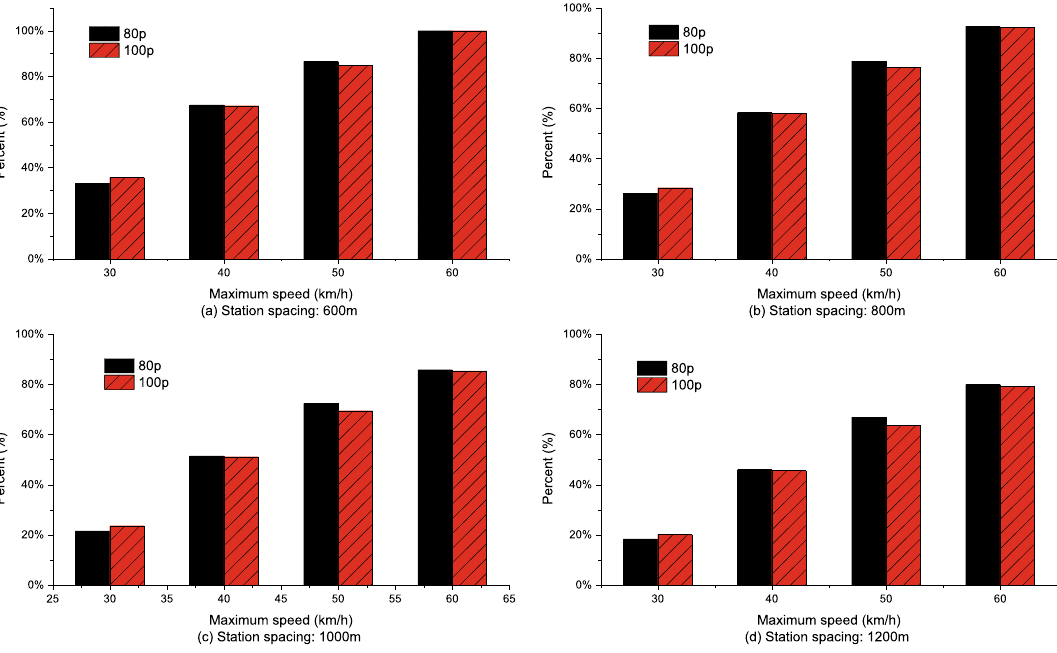
v = 0.6 m/s 2 . d t